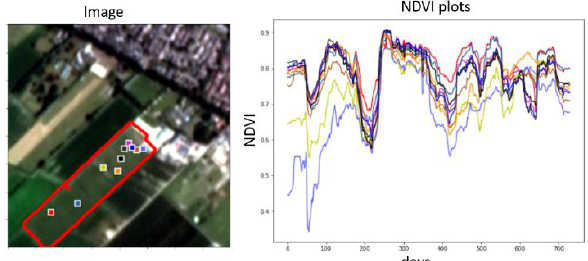
Figure 2. Left: An example RapidAI4EO patch, a field inside that patch (red polygon in the left image), and ten sample points inside the field. Right: 2-year NDVI time-series (right) of the collected ten samples for the given